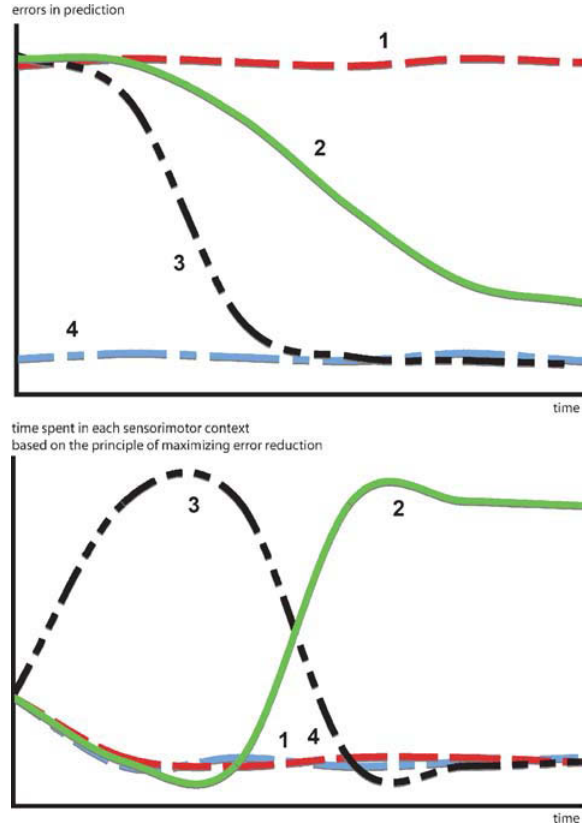
Figure 1. How a progress-driven control system operates on an idealized problem. Confronted with four sensorimotor contexts characterized by differ- ent learning profiles. The motivation for maximizing learning progress results in avoiding situations already predictable (context 4) or too difficult to predict (context 1), in order to focus first on the context with the fastest learning curve (context 3) and eventually, when the latter starts to reach a “plateau” to switch to the second most promising learning situation (context 2). This intrinsic motivation system allows the creation of an organized exploratory strategy necessary to engage in open-ended